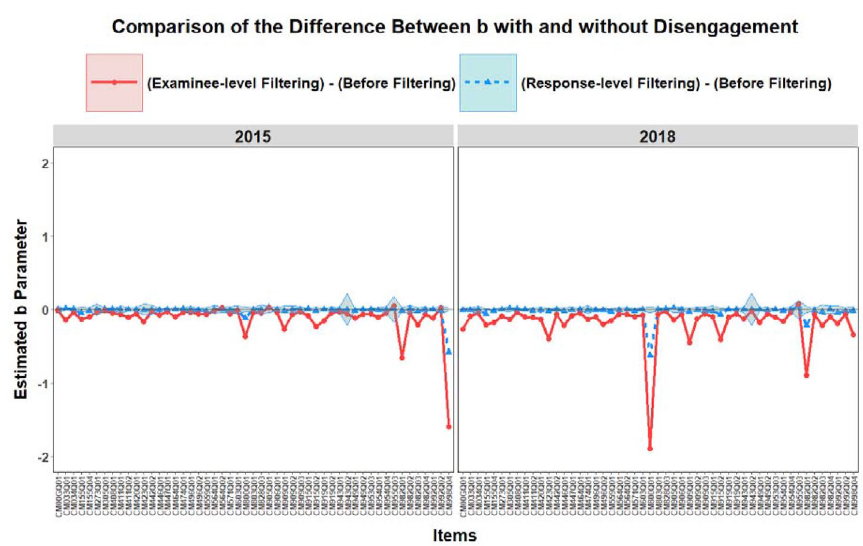
Fig. 5 Comparison of the difference between b with disengagement and without disengagement. The blue line refers to the difference between b with disengagement and after applying response-level filtering; the red line refers to the difference between b with disengagement and after applying examinee-level filtering; and the light green represents the range of the SE of the b parameter estimates with disengagement (i.e., before filtering). Source : Organisation for Economic Co-operation and Development (OECD), Programme for International Student Assessment (PISA), 2015 and 2018 Mathematics